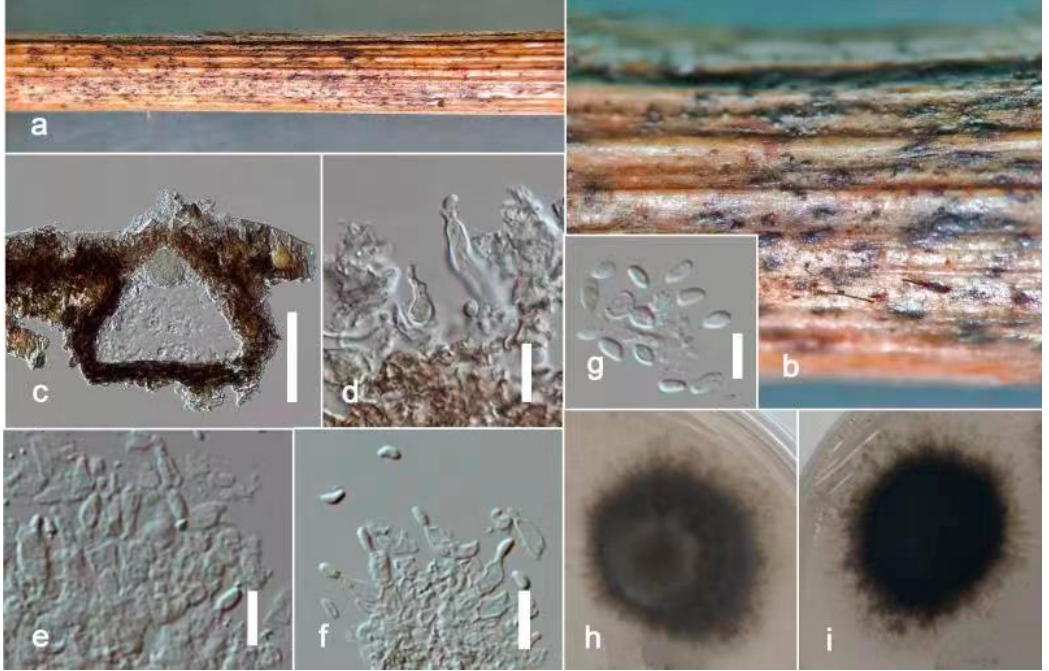
Figure 6. Remotididymella fici - microcarpae (ZHKU 22-0095, holotype ). ( a , b ) Conidiomata on the substrate. ( c ) Vertical section of a conidioma. ( d – f ) Conidiogenous cells attached to conidia. ( g ) Conidia. ( h ) Surface view of colony on PDA. ( i ) Reverse view of colony on PDA. Scale bars: c = 100 µm, d – g = 15 µm.